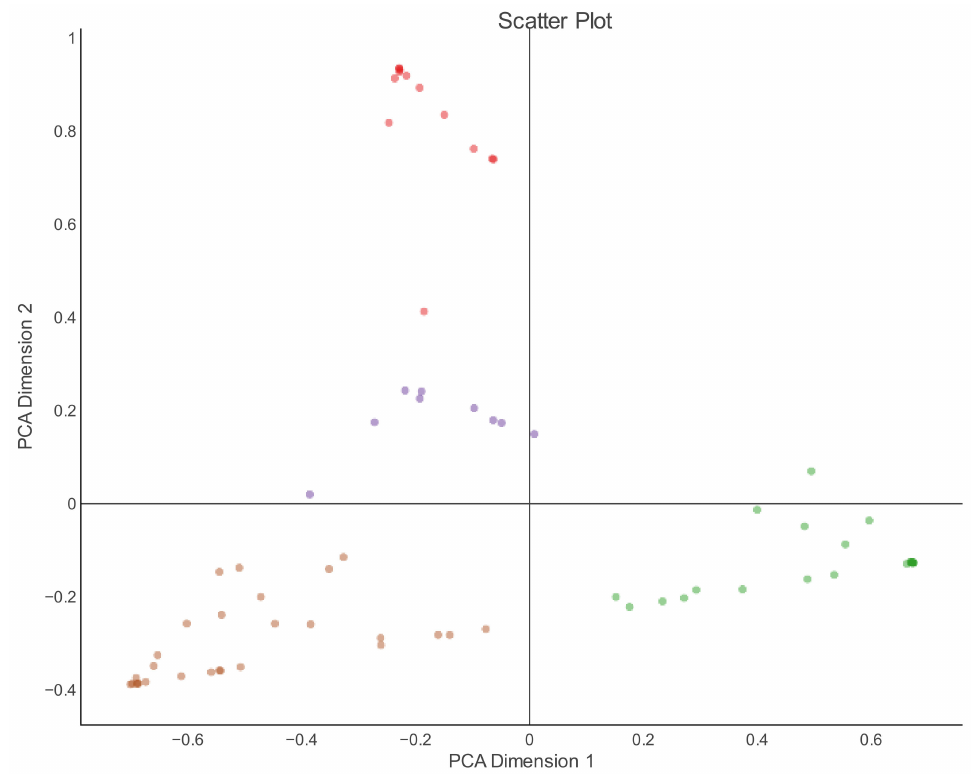
Figure 5. PCA-based distribution of patents in four LDA topics in the factorial